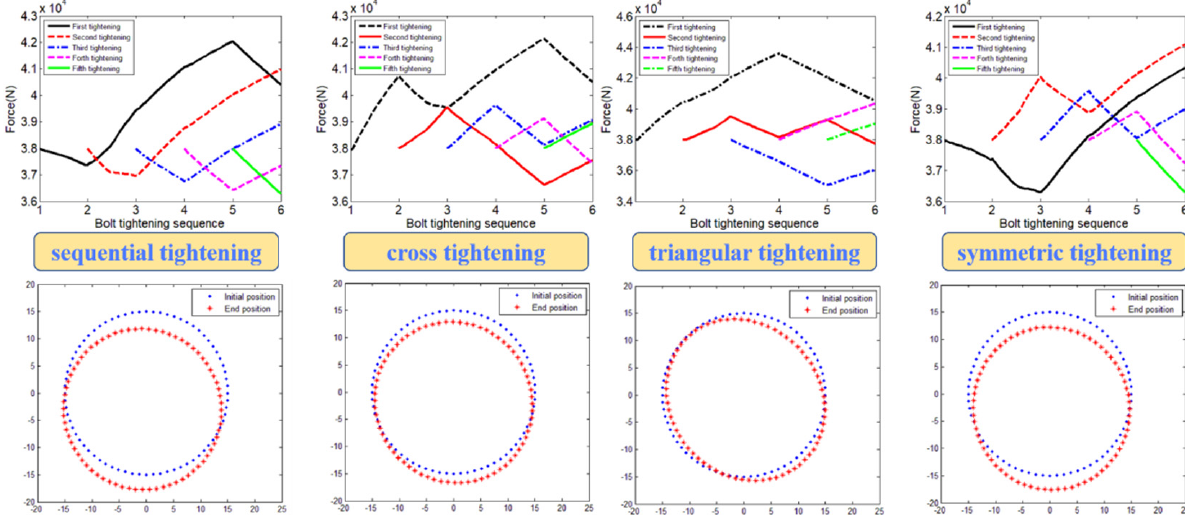
Figure 9. Comparison of the effects of four tightening sequences on the change law of bolt preload and flange deformation [51].